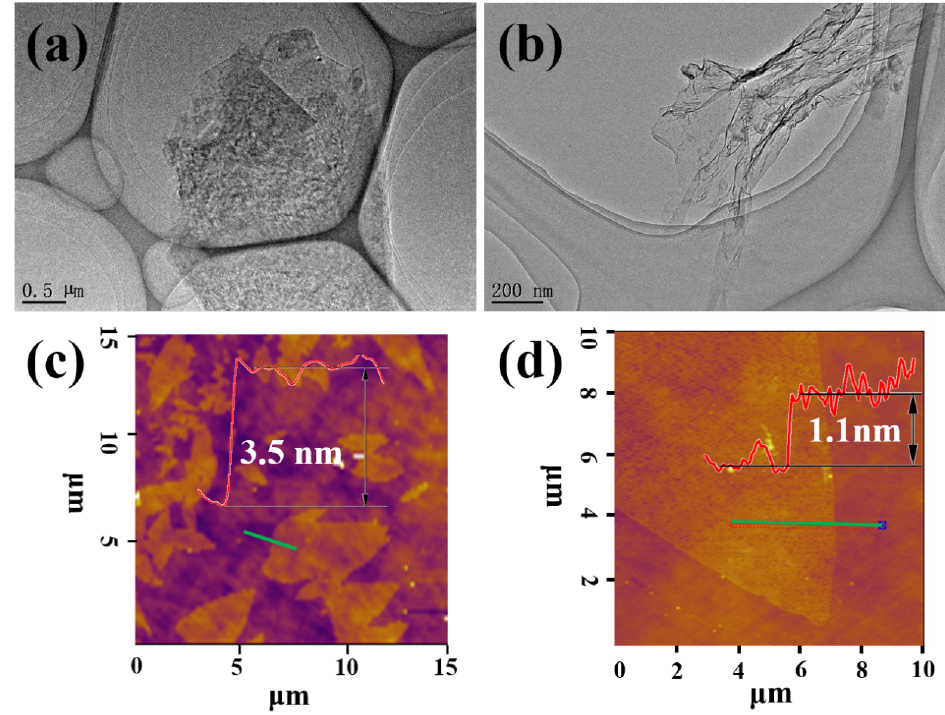
Figure 2. TEM and AFM images of the MoS 2 ( a , c ) and graphene ( b , d ).